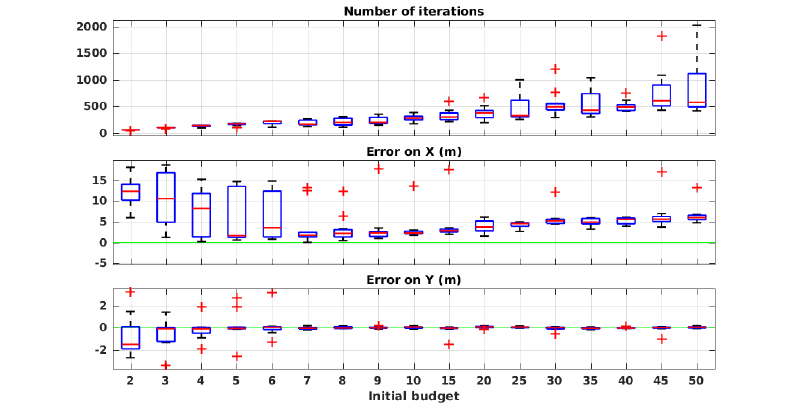
Figure 12. Evaluation results in simulation with different initial values of the sample